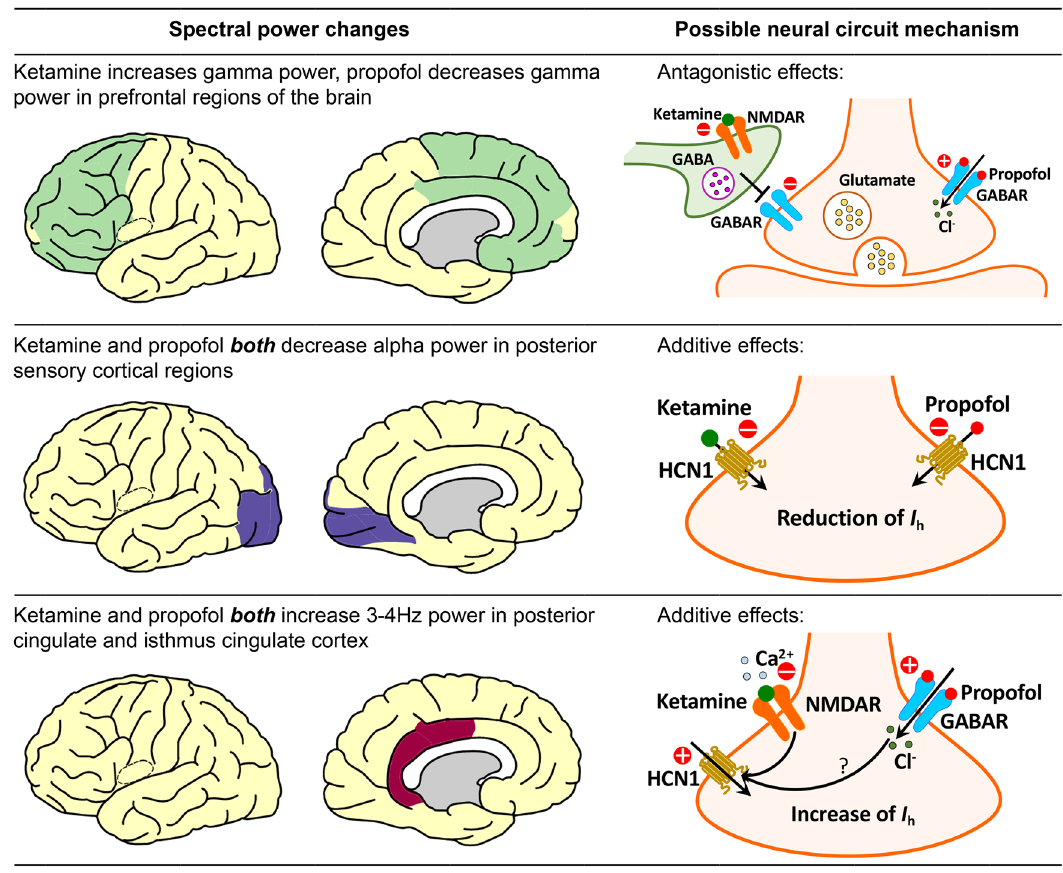
Fig. 5 | Possible neural circuit mechanisms forsubanesthetic dose ofketamine and propofol-induced spectral power changes studied here (Please refer to Zanos et al. , 2018 for a more comprehensive view of the possible mechanisms of ketamine ’ s action as an antidepressant 51 . This fi gure was produced using the Simple-brain-plotMATLABfunction 66 andstockdrawingsofneuronsandreceptors